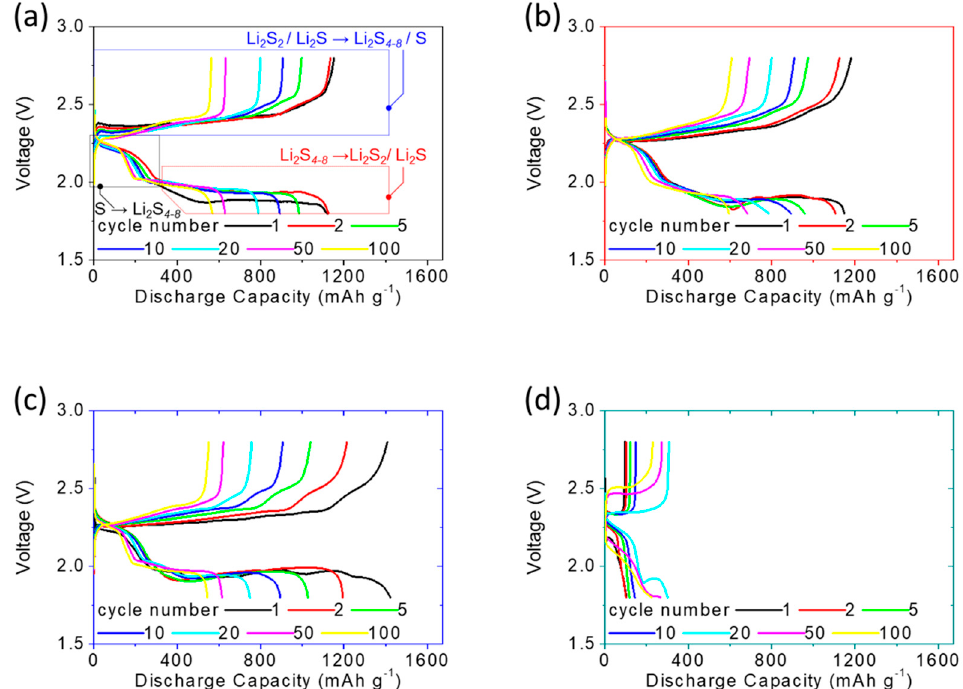
Figure 5. Electrochemical analysis: discharge/charge voltage profiles of the sulfur cathodes at the C/10 rate with ( a ) the carbon-nanofoam interlayer, ( b ) the MoS 2 -coated carbon-nanofoam interlayer, ( c ) the graphene-coated carbon-nanofoam interlayer, and ( d ) the reference cathode.